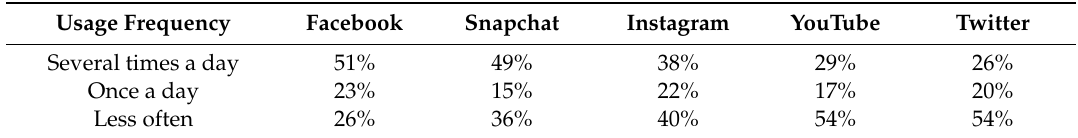
Table 2. Percentage of U.S. adults that use each site.